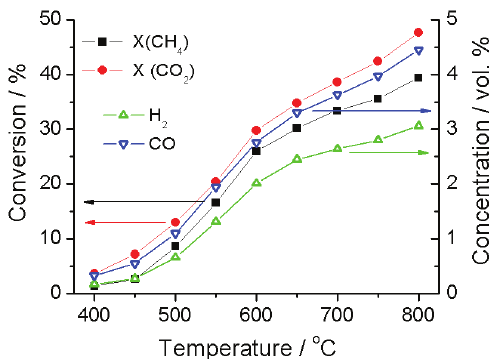
Figure 18a: Temperature dependence of reagents conversions and products concentrations for 5Ni/Ce + 5% CO in He. Contact time 8 ms, pretreatment 1 h at 400 o C in O 2 followed by 1h at 400 o C in 10% H